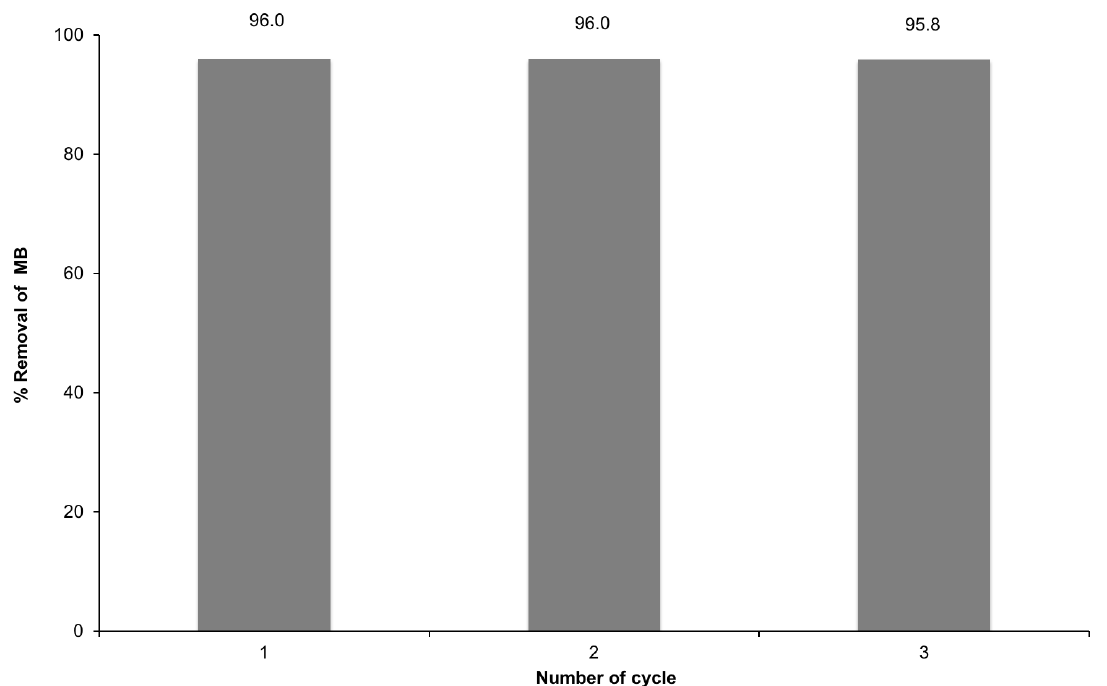
Figure 10. Removal efficiency of PEGCD1 for MB during three consecutive adsorption/desorption Figure10. Removale ffi ciencyofPEGCD1forMBduringthreeconsecutiveadsorption / cycles.